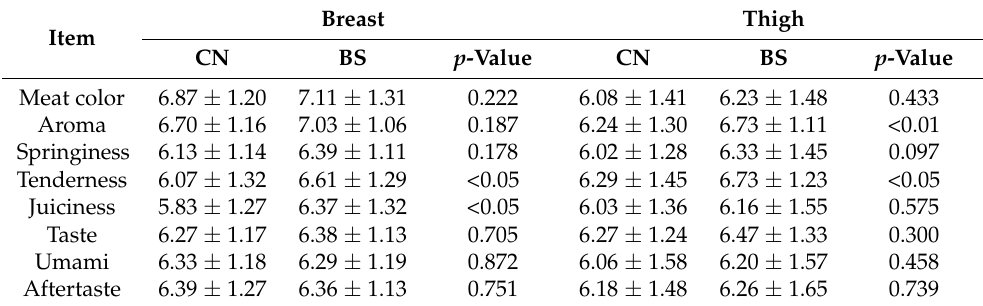
Table 9. Effects of dietary Brevibacillus laterosporus S62-9 on the sensory properties of chicken meat. Breast Item